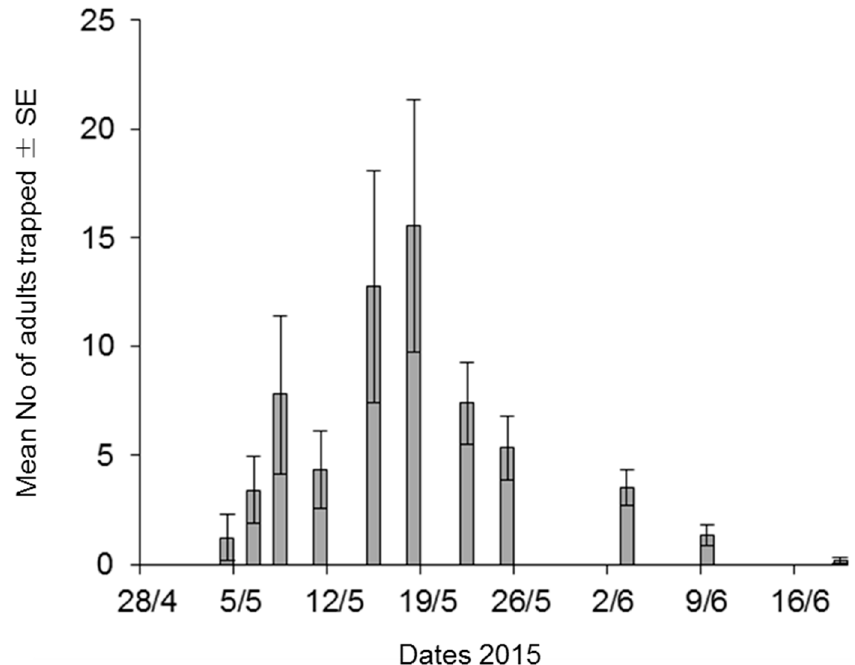
Figure 7. Trapping trends of Rhagoletis cerasi during the cherry maturing period of 2015 in the reference organic cherry farms.